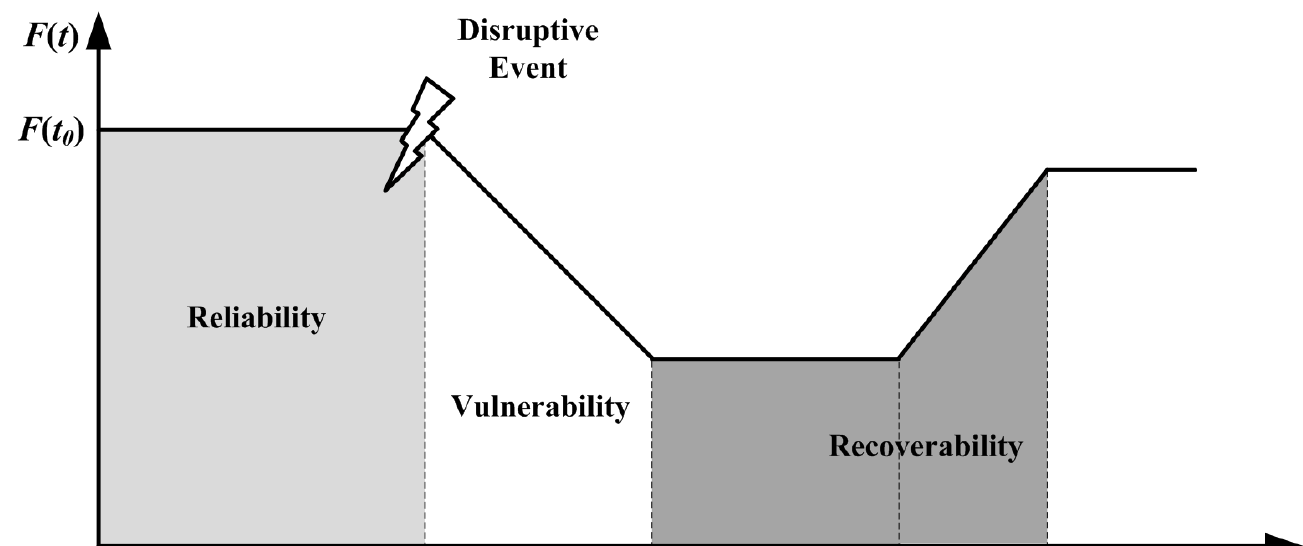
Figure 1. Performance transition of a resilient system.